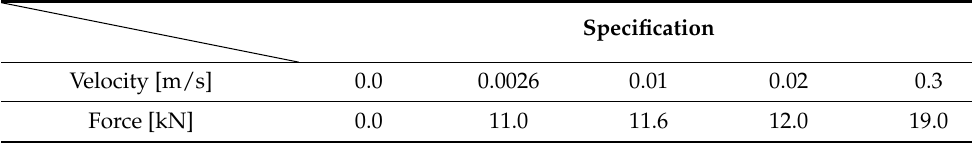
Table 2. Specifications of an anti-yaw damper.